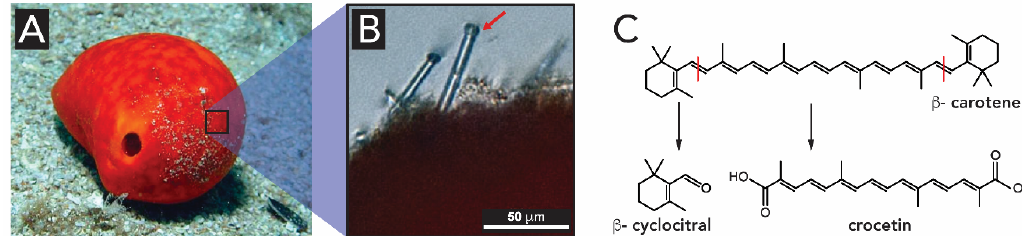
Figure14. Lightharvestingsystemin S.domuncula. ( A )Aspecimenofthedemosponge S.domuncula fromthe AdriaticSea. ( B )Detailofthesurfaceofthespongesshowsprotrudingspicules,tylostyles(uniradiatepointed sponge spicule with a knob at the blunt end) (arrow), which expose their spherical / elliptical knobs to the external environment, while the tips remain inside. Scale bar: 50 µ m. ( C ) The carotenoids found in S. domuncula ; they are the degradation products from b-carotene (identified as crocetin and b-cyclocitral). Image ( A ) by Anne Frijsinger and Mat Vestjens, 2004. Images ( B , C ) Adapted from [100] under the Creative Commons Attribution 4.0 International